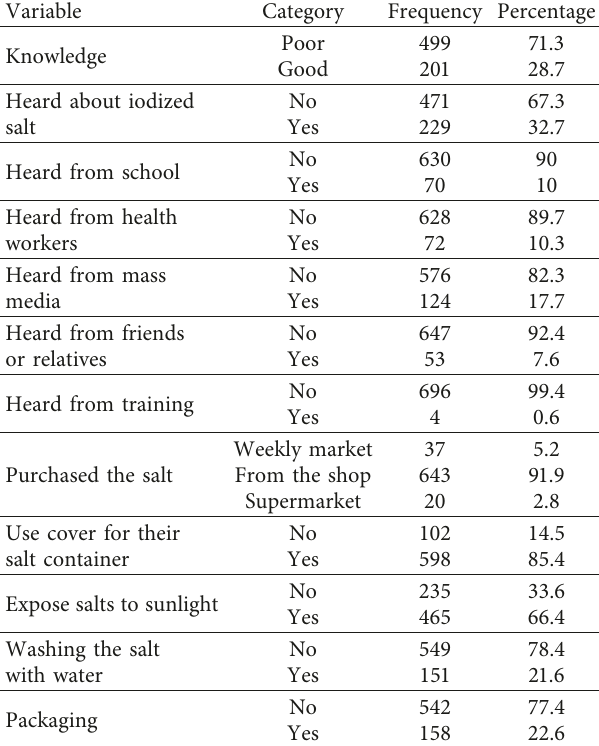
Table 2: Knowledge on iodized salt at the household level in Western Amhara, Ethiopia, 2018 ( N � 700).